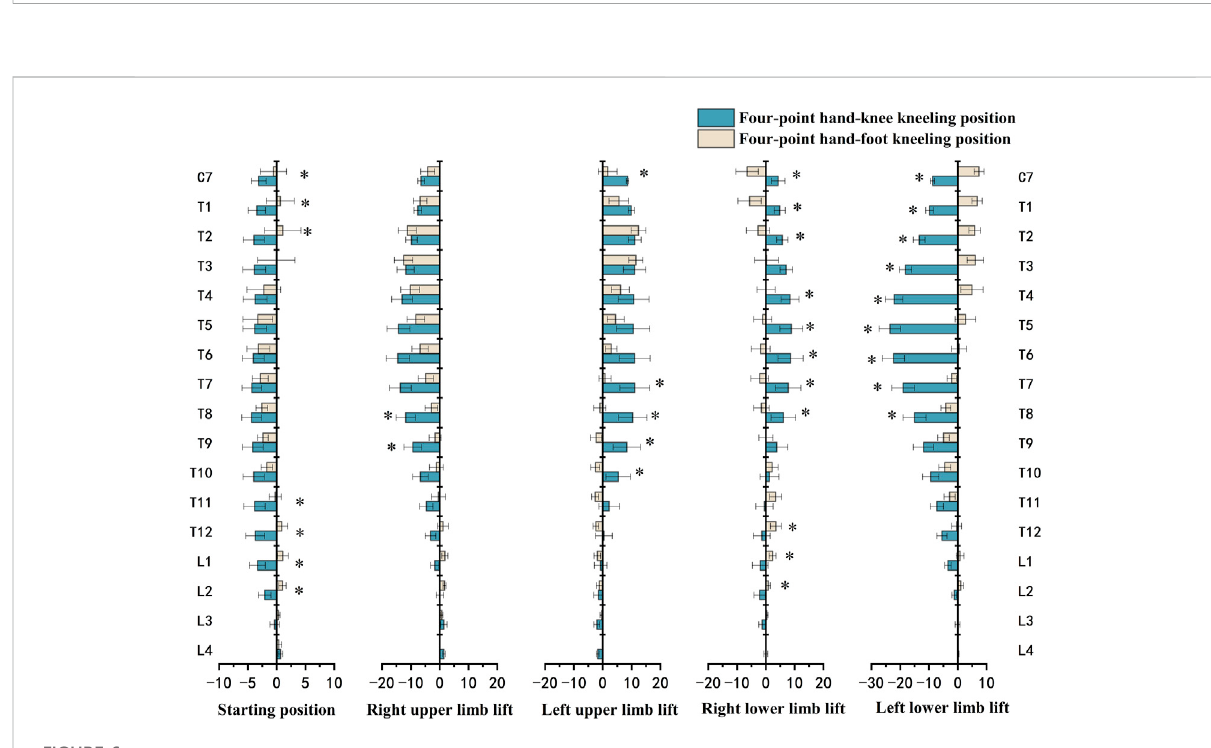
FIGURE 6 Comparison of vertebral rotation ( ° ) between the four-point hand − knee and hand − foot kneeling positions. The negative value meant the vertebra rotates to the left; the positive value meant the vertebra rotates to the right. *: statistically signi fi cant, p < 0.05.